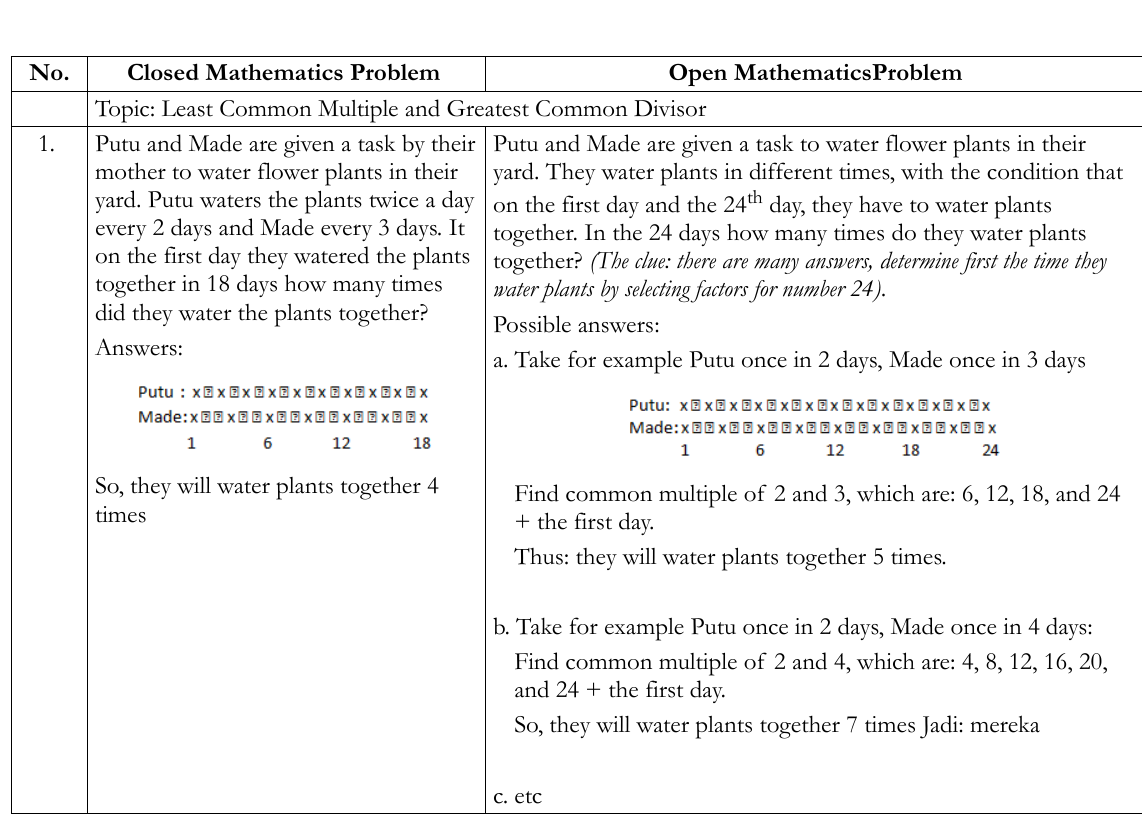
Table 1. Comparison between Open Mathematics Problem and Closed Mathematics